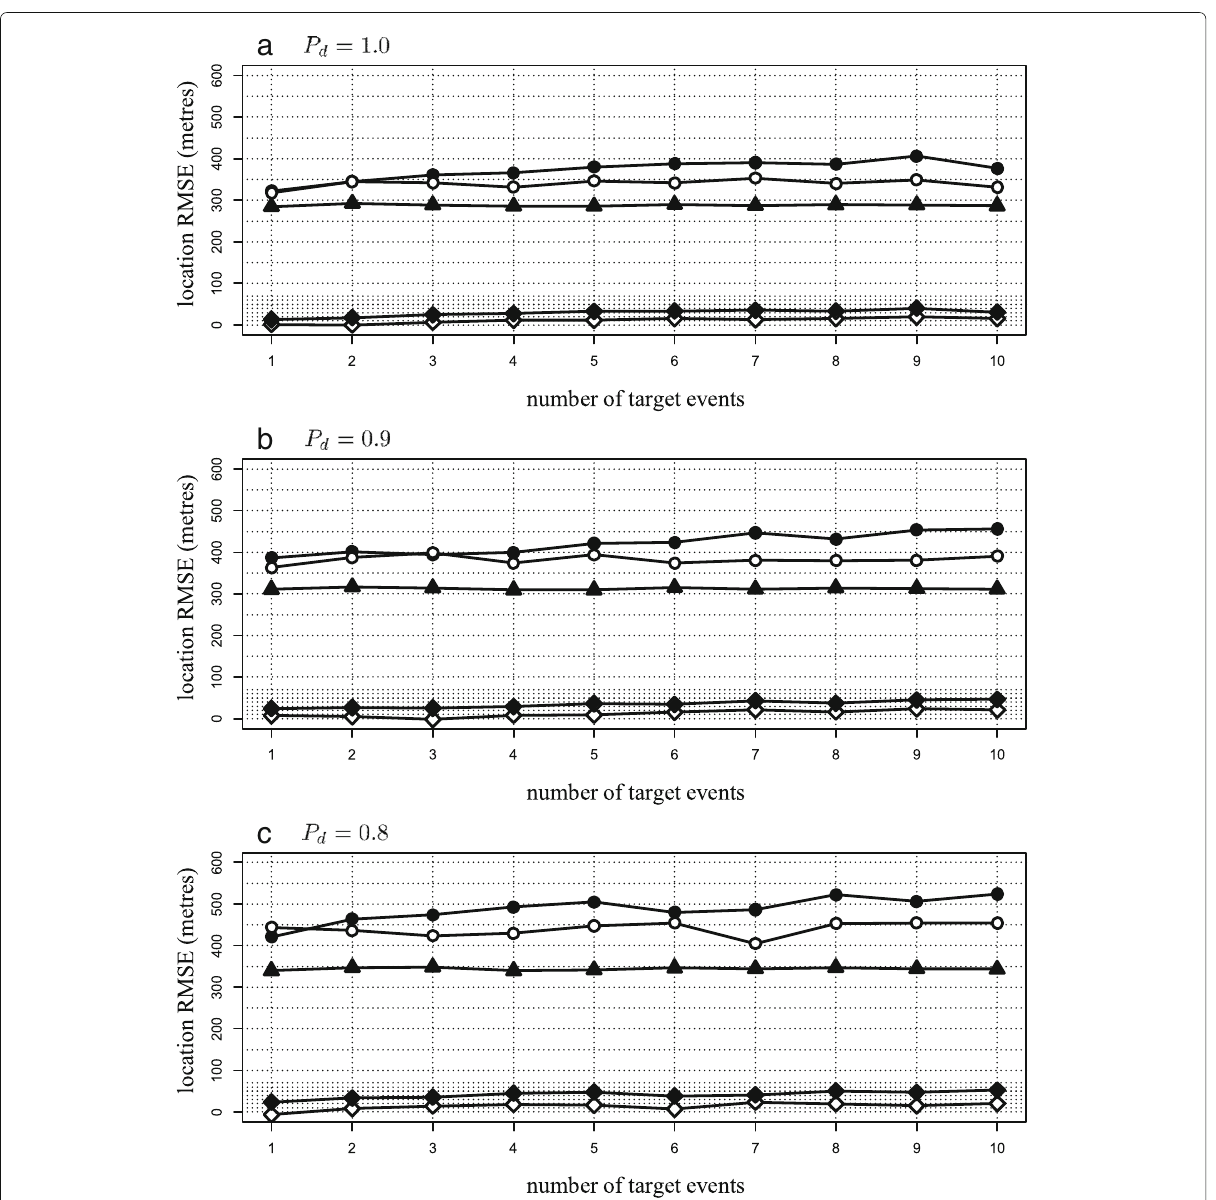
Fig. 5 Target localisation performance for scenario 2. The TALA RMSE ( blackcircles ), gTALA RMSE ( whitecircles ), and the CRLB RMSE ( blacktriangles ). The percentage differences between the performance of the TALA and ( i ) the CRLB ( blackdiamonds ) and ( ii ) the gTALA ( whitediamonds ). Results are averaged over all 1000 simulations. a P d = 1.0. b P d = 0.9. c P d =